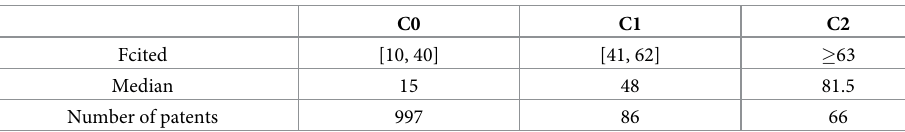
Table 2. Data classification